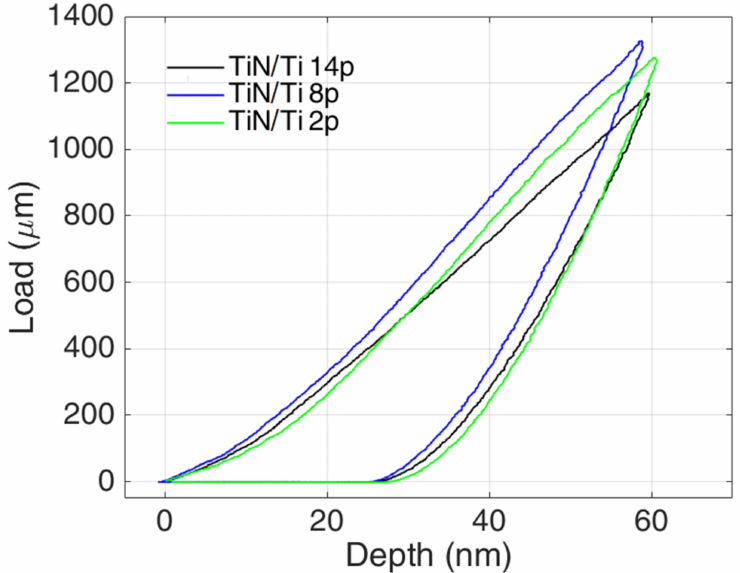
Figure 11. Load versus depth-load of TiN/Ti samples.